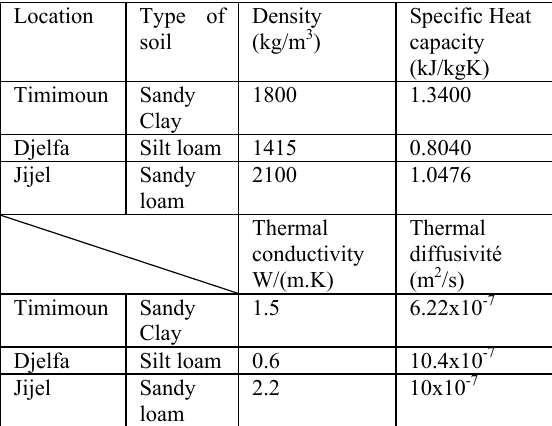
Figure 2. Variation of solar irradiation in different locations in Algeria. Table 3. Soil characteristics in three different